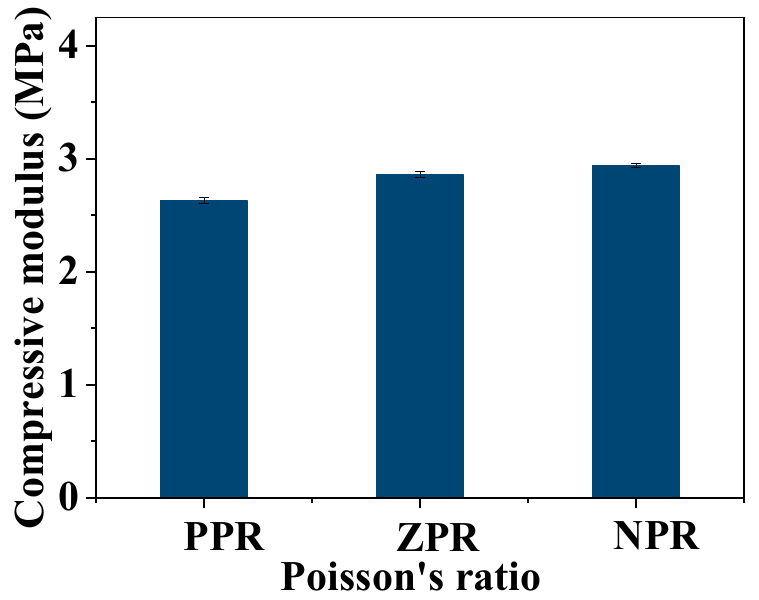
Figure 4. Compression modulus of CNF/PEGDA aerogels with different Poisson’s ratios.